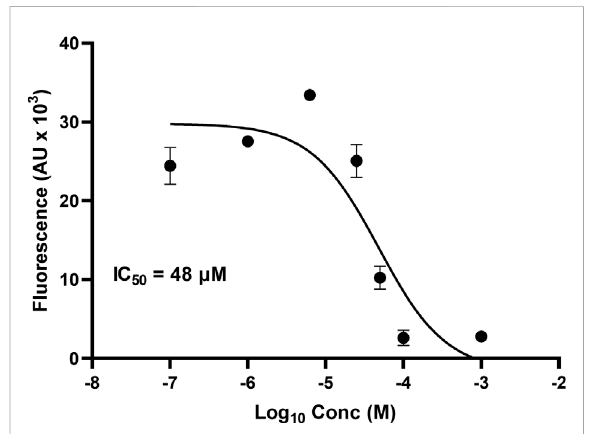
FIGURE 2 AlphaScreen IC 50 . IC 50 of A9 determined to be 48 μ M through dose-dependentAlphaScreenstudies(intriplicate). X -axisislog[A9], and Y -axisisthe fl uorescenceintensity(AUX10 3 ).IC 50 derived from a three-way parameter model on GraphPad